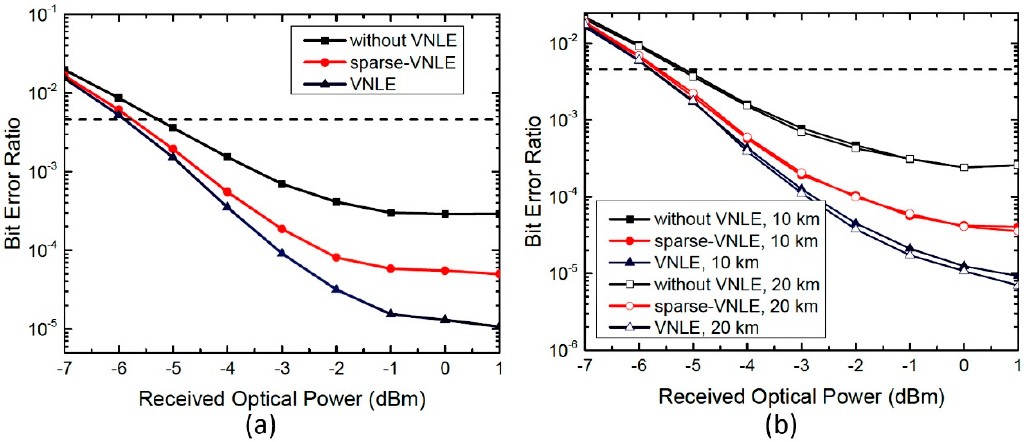
Figure 16. ( a ) BER vs. received optical power for a back-to-back system. ( b ) BER vs. received optical power for 10 km and 20 km transmission (reprinted from [31] with permission from authors).